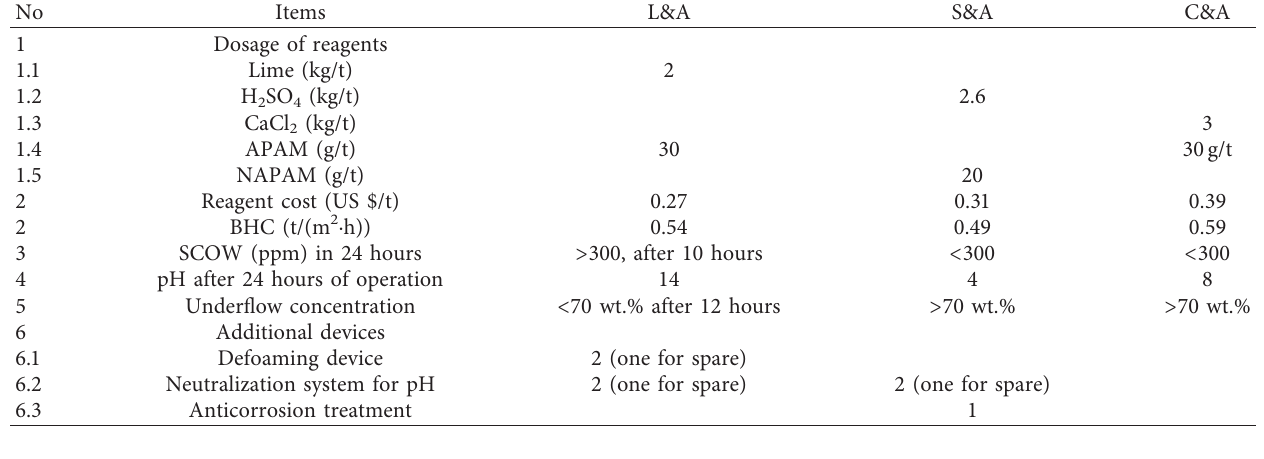
Table 3: Comparison of different dewatering schemes.